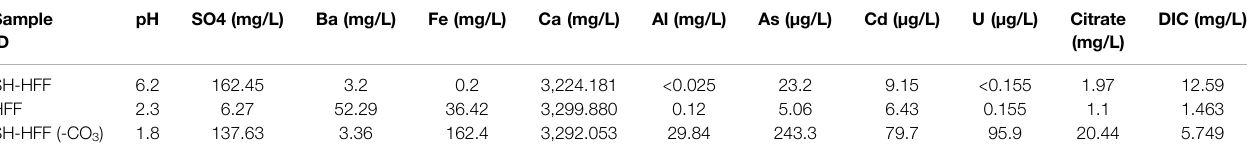
TABLE 3 | pH, IC and ICP-MS fl uid chemistry results for each reaction and control fracturing fl uid (with no shale). Sample ID